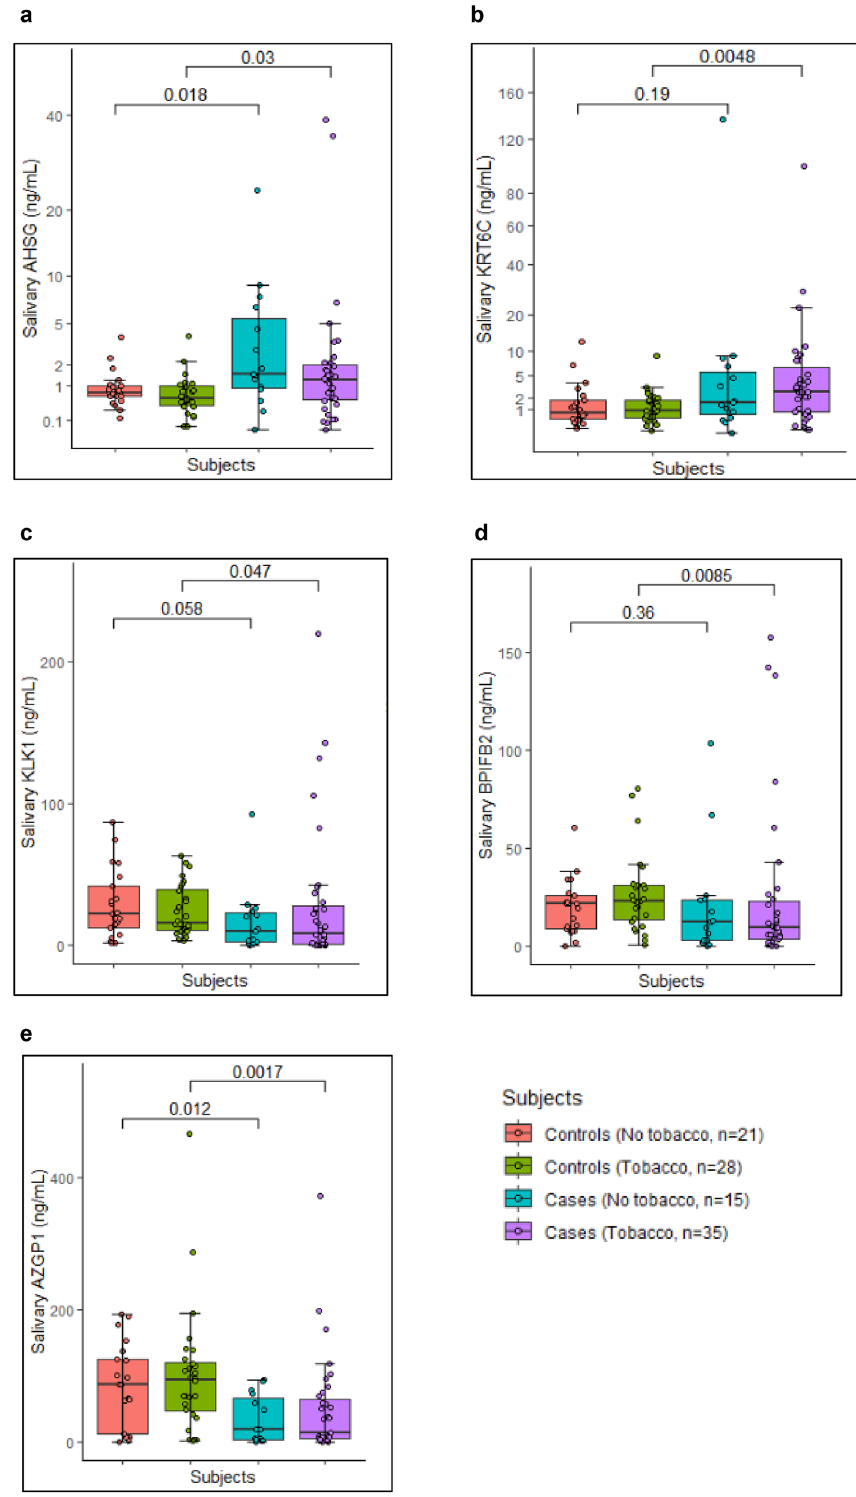
Figure 4. Levels of significantly dysregulated proteins as tobacco consumption habits of study subjects. Boxplot representing the levels of significantly dysregulated proteins amongst controls and OSCC cases with and without tobacco consumption habits. ( a ) AHSG was upregulated in cases compared to controls irrespective of the tobacco consumption habits ( b ) KRT6C was significantly upregulated in cases having tobacco consumption habits. Proteins ( c ) KLK1 and ( d ) BPIFB2 were downregulated in cases with tobacco consumption habits. ( e ) AZGP1 was significantly downregulated in cases irrespective of the tobacco consumption habits. Wilcoxon sum rank test was used to compare the median protein levels of controls and cases (p < 0.5 was the cut off for statistical